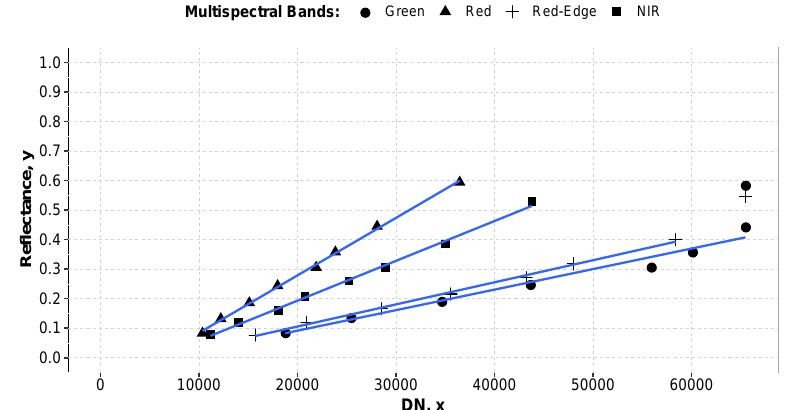
Figure 5. Linear relationships between image raw digital numbers (DN) and surface reflectance in each multispectral band. The green and red-edge band sensors were saturated for the 5% reference surface and therefore that measurement was excluded from fitting linear